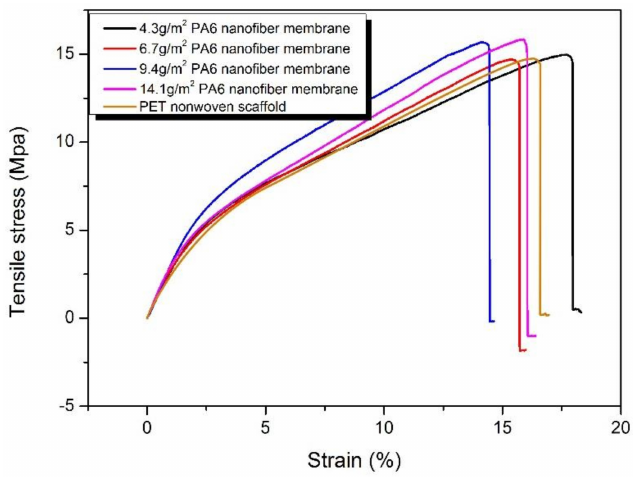
Figure 8. Tensile fracture curve of different areal densities of